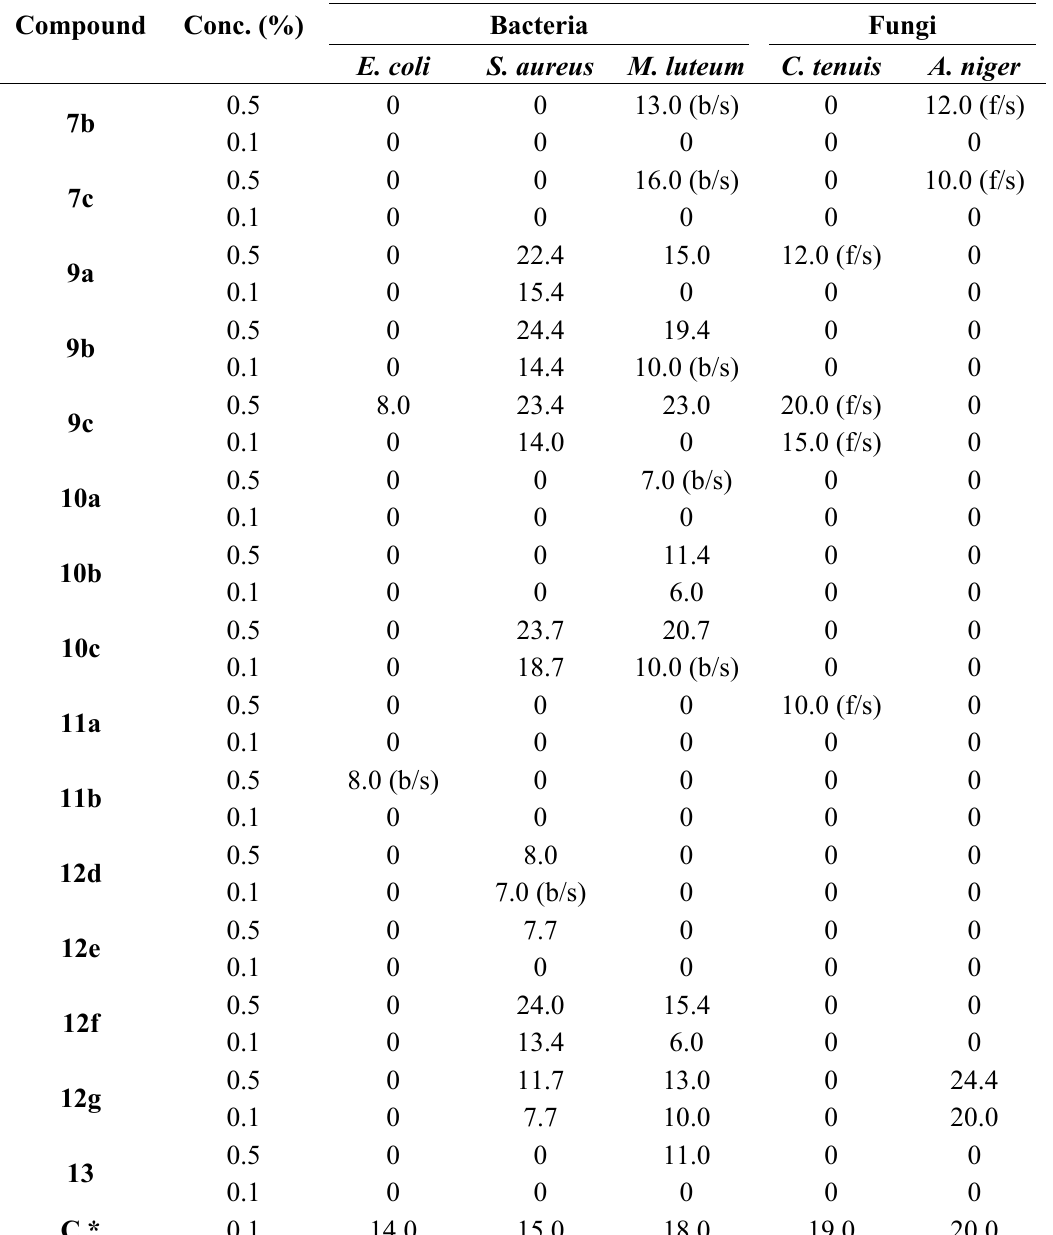
Table 1. Antimicrobial activity of the synthesized compounds determined by diffusion method (only compounds that gave positive results at least in one case are included in the